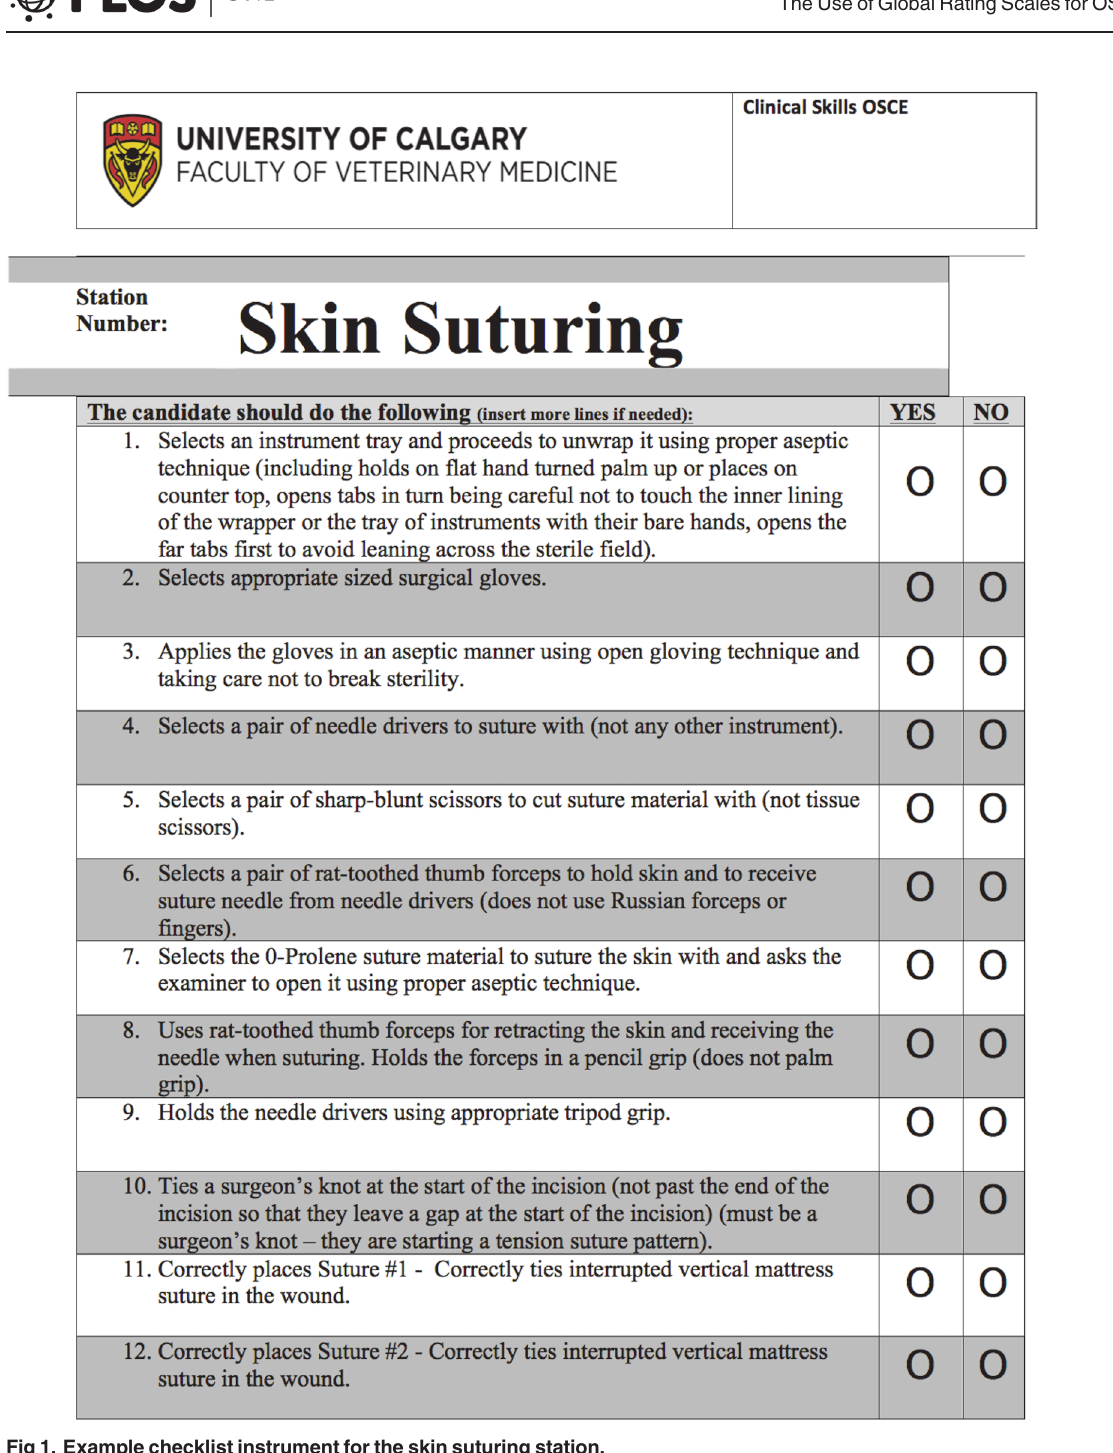
Fig 1. Example checklist instrument for the skin suturing